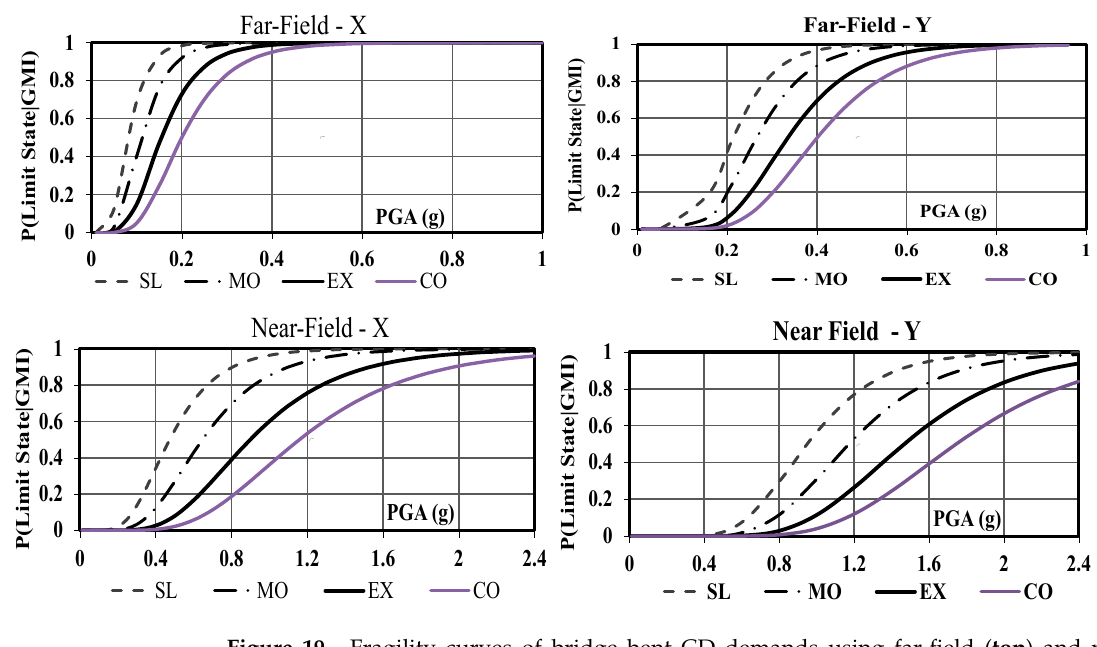
Figure 18. IDA results of bridge bents bearing displacement (BD) demands using far-field ( top ) and near-source ( bottom ) input ground motions in the longitudinal ( left ) and transverse ( right ) direc- tions of the benchmark bridge along with the power law equations.